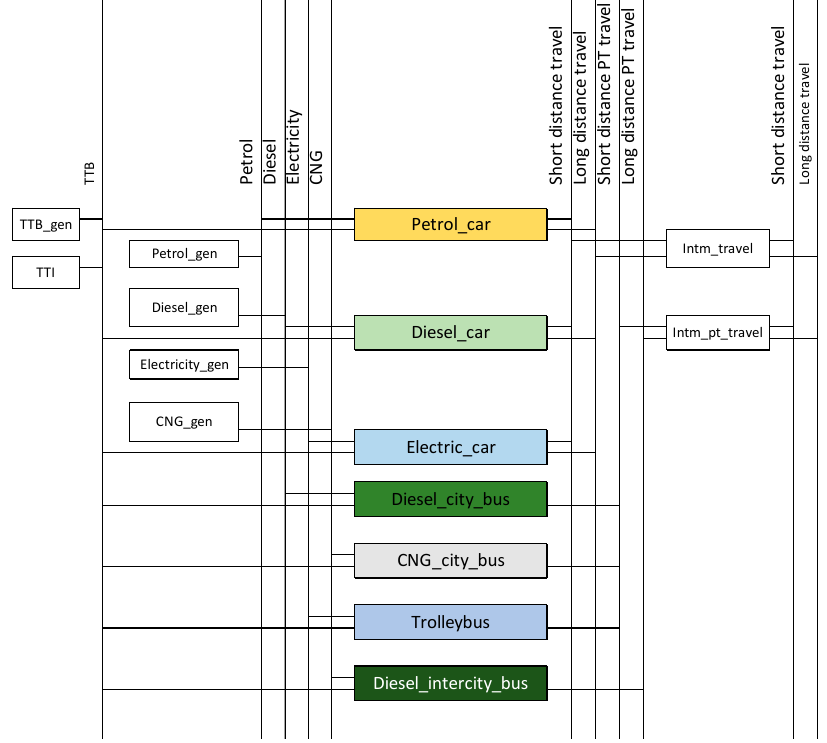
Figure 5. The reference scheme of a traditional modeling approach for the passenger transport sec- tor.